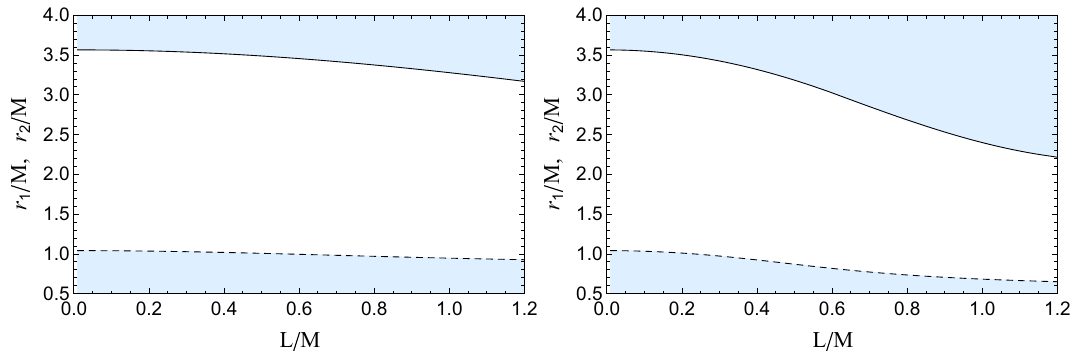
Fig. 8 DependenceoftheboundariesoftheSECintheregularrotating black hole spacetime in conformal gravity on the dimensionless param- eter L / M . In the left panel , we have a / M = 0 . 7 and N = 1, while in